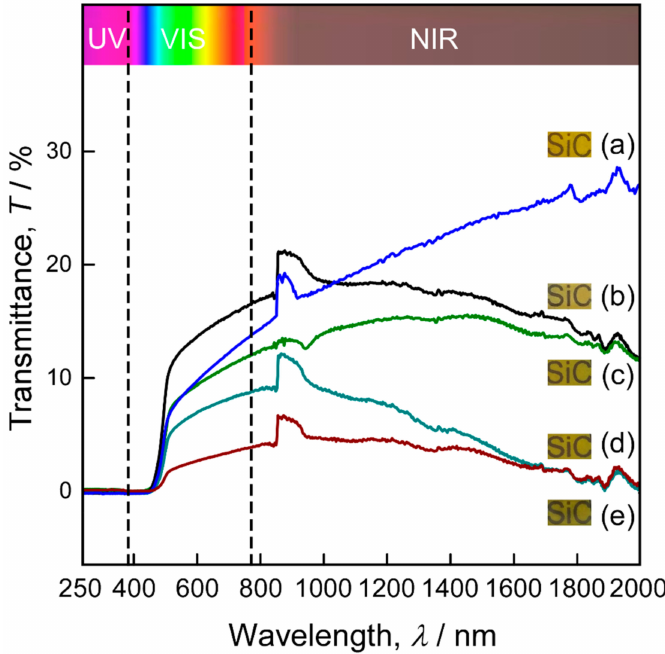
Figure 6. Photograph and optical transmission curves of mirror-polished N-doped 3C-SiC